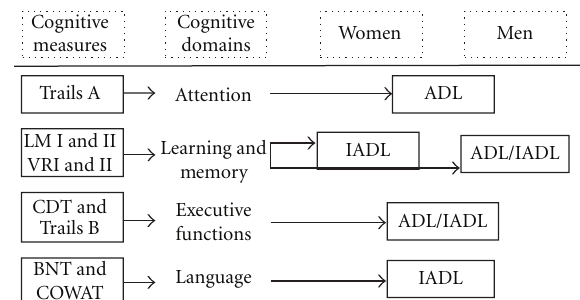
Figure 1: Predicting ADL and IADLs in men and women with